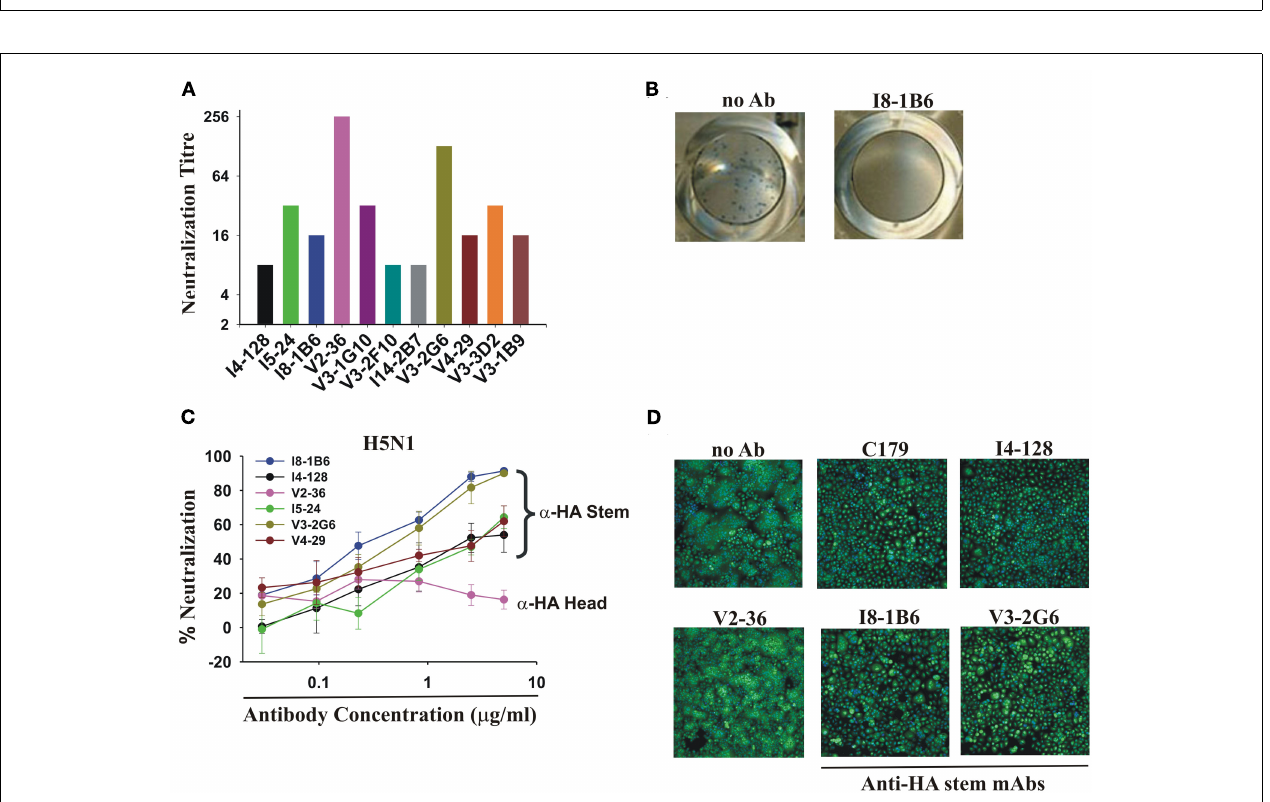
FIGURE 3 |Vaccines for seasonal influenza or pdmH1N1 and purified recombinant HA from highly pathogenic avian H5N1 influenza exhibit the epitope targeted by anti-HA stem mAbs. ELISA reactivity with the 2009/2010 seasonal influenza vaccine, the pdmH1N1 vaccine, and purified